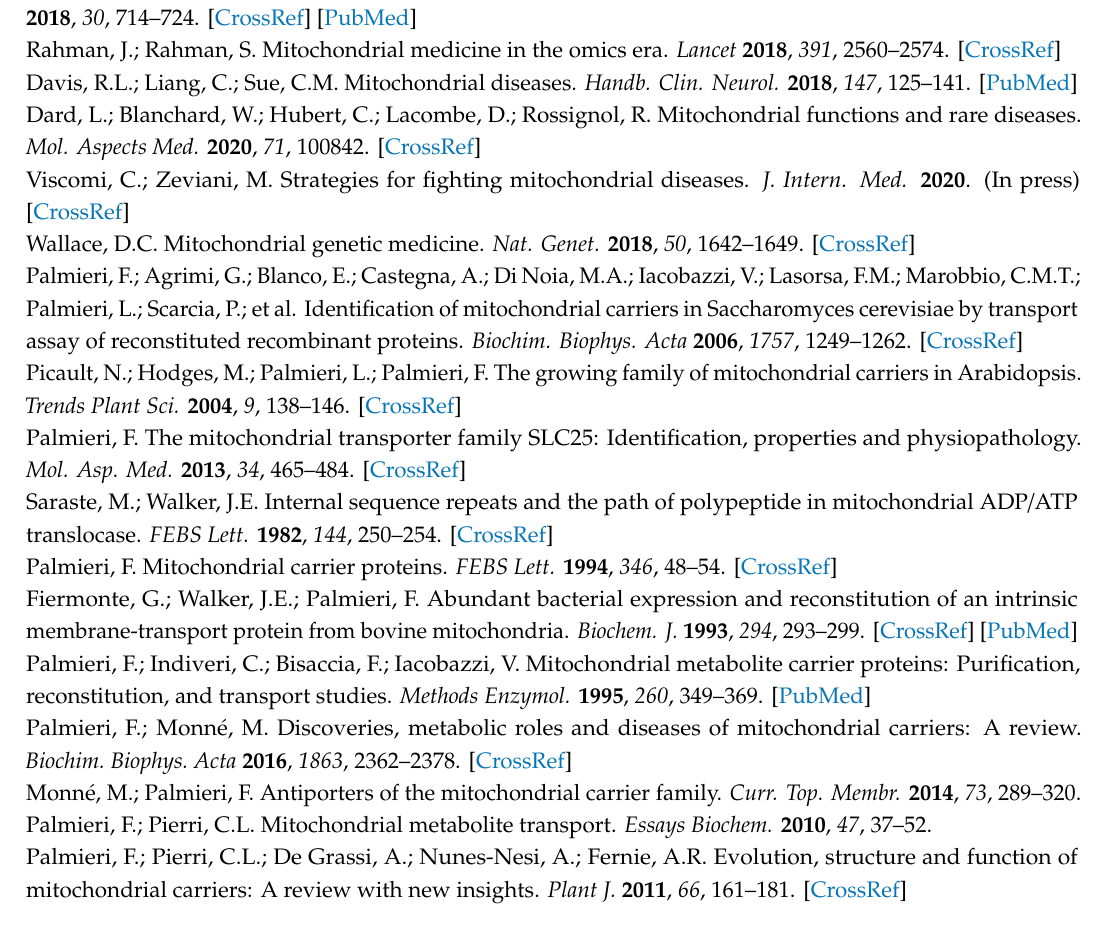
Table S1: Disease-causing mutations in mitochondrial